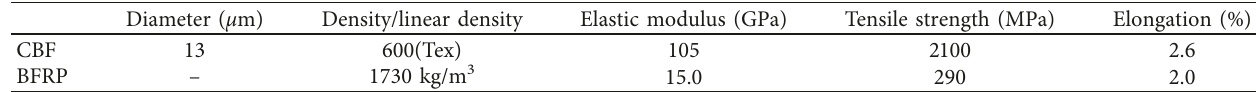
Table 4: Parameters of continuous basalt fiber and its composite.